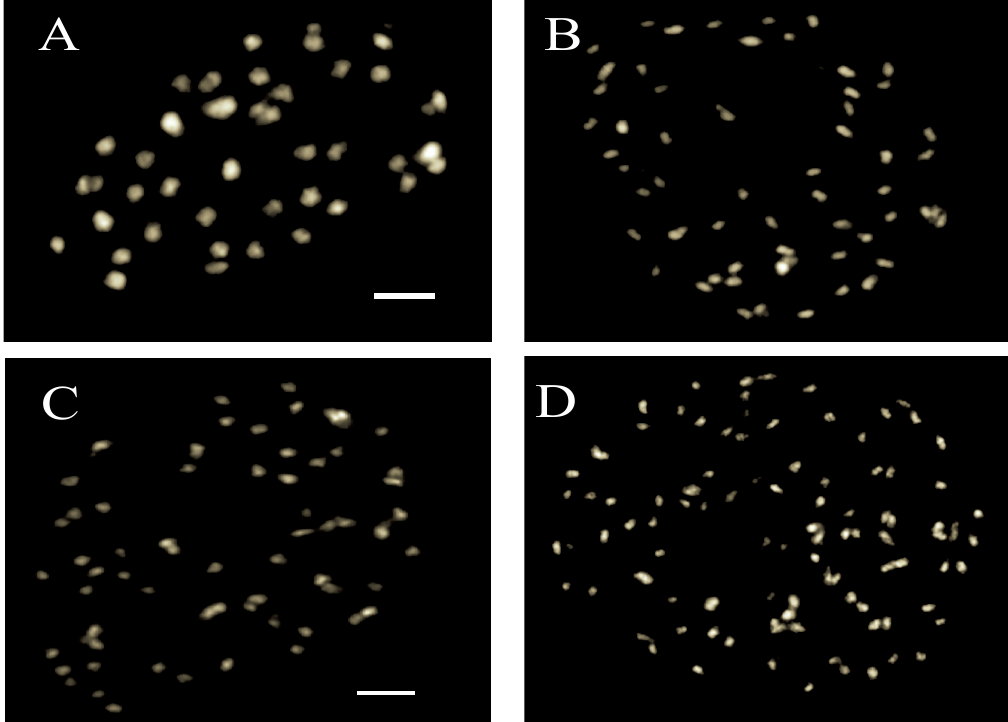
Figure 2. Mitotic metaphase chromosome spreads of ( A ) D. rotundata (TDr-2763 = 2n = 2x = 40); ( B ) D. alata (TDa-1030 = 2n = 3x = 60); ( C ) D. dumetorum (TDd-3778 = 2n = 3x = 60); and ( D ) D. esculenta (TDes-3038 = 2n = 4x = 80). Scale bar: 5 µm.